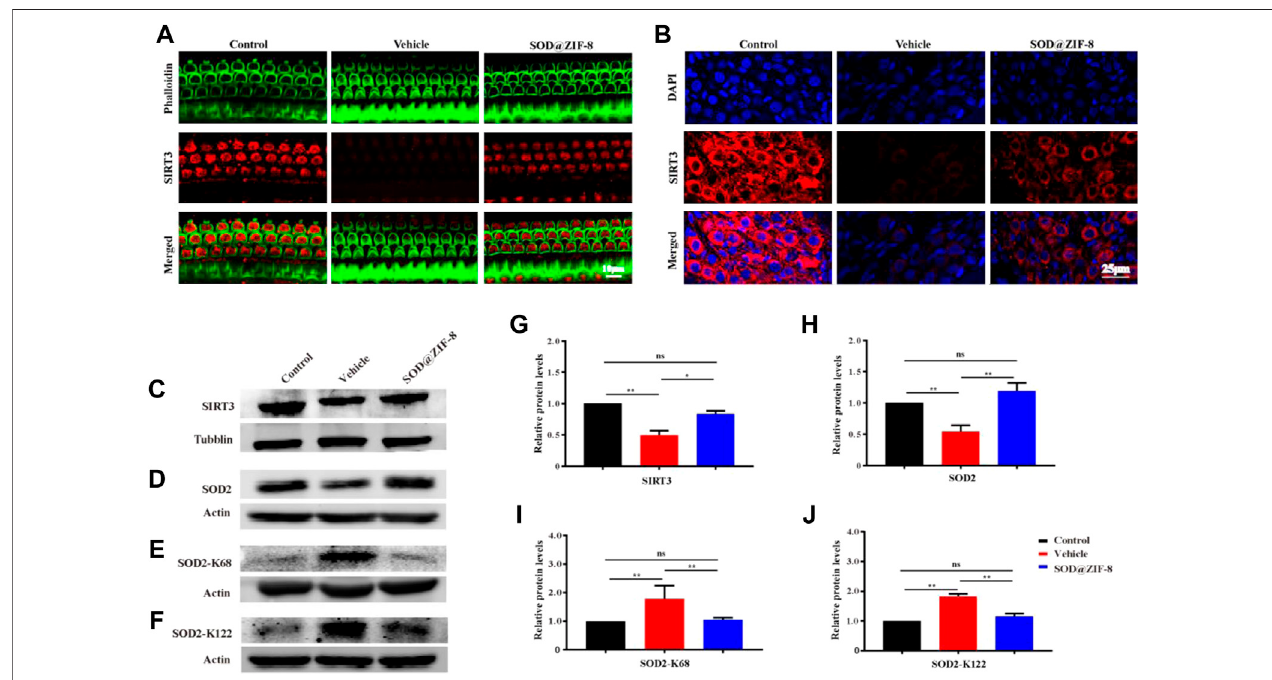
FIGURE 7 | Superoxide dismutase (SOD)@zeolite imidazolate framework-8 (ZIF-8) administration counteracted the decrease of Sirtuin-3 (SIRT3) and SOD2 causedbynoise. (A) RepresentativeimagesofSIRT3staininginspiralganglionneurons(SGNs)ofthemiddle – basalcochlearturnsfromthreegroups. (B) Representative imagesofSIRT3staininginouterhaircellsofthebasalcochlearturnsfromthreegroups. (C – J) ProteinexpressionlevelsandstatisticalanalysesofSIRT3,SOD2,SOD2- K68, and SOD2-K122 in the cochleae of various groups. Data are presented as means ± standard deviation (SD) (* p < 0.05, ** p < 0.01, ns: no statistical signi fi